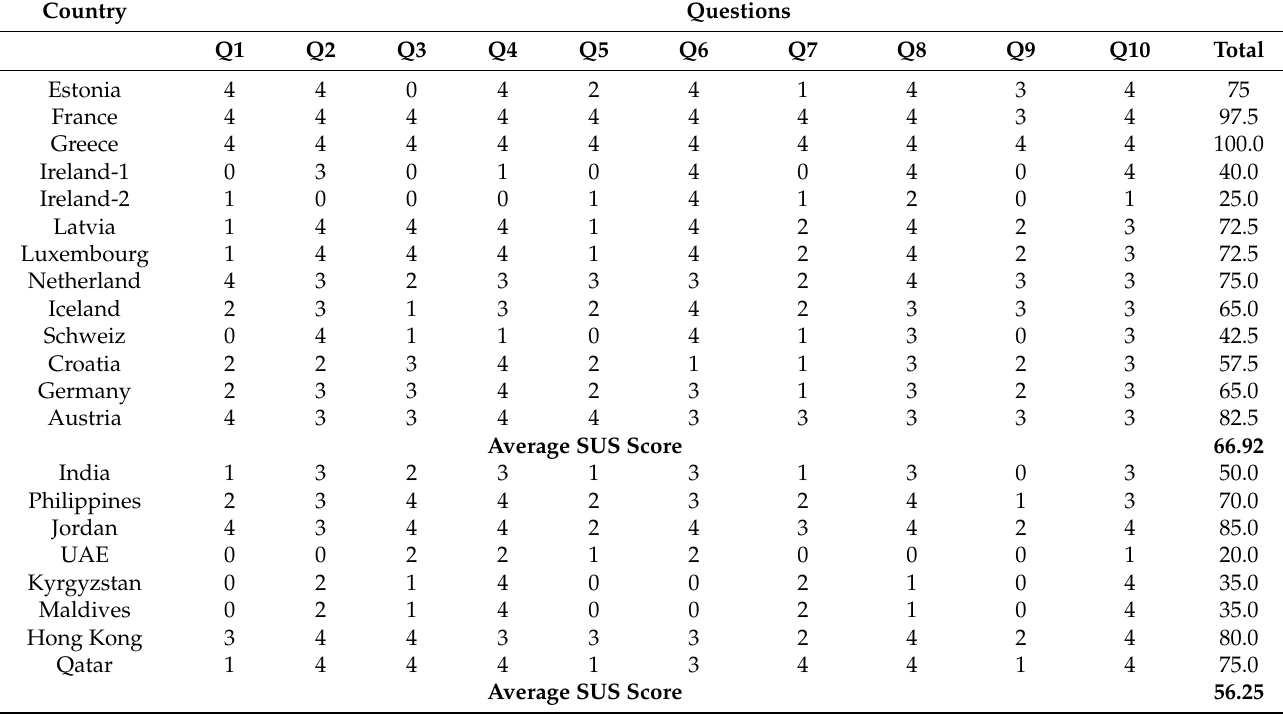
Table 13. Questionnaire-based System Usability